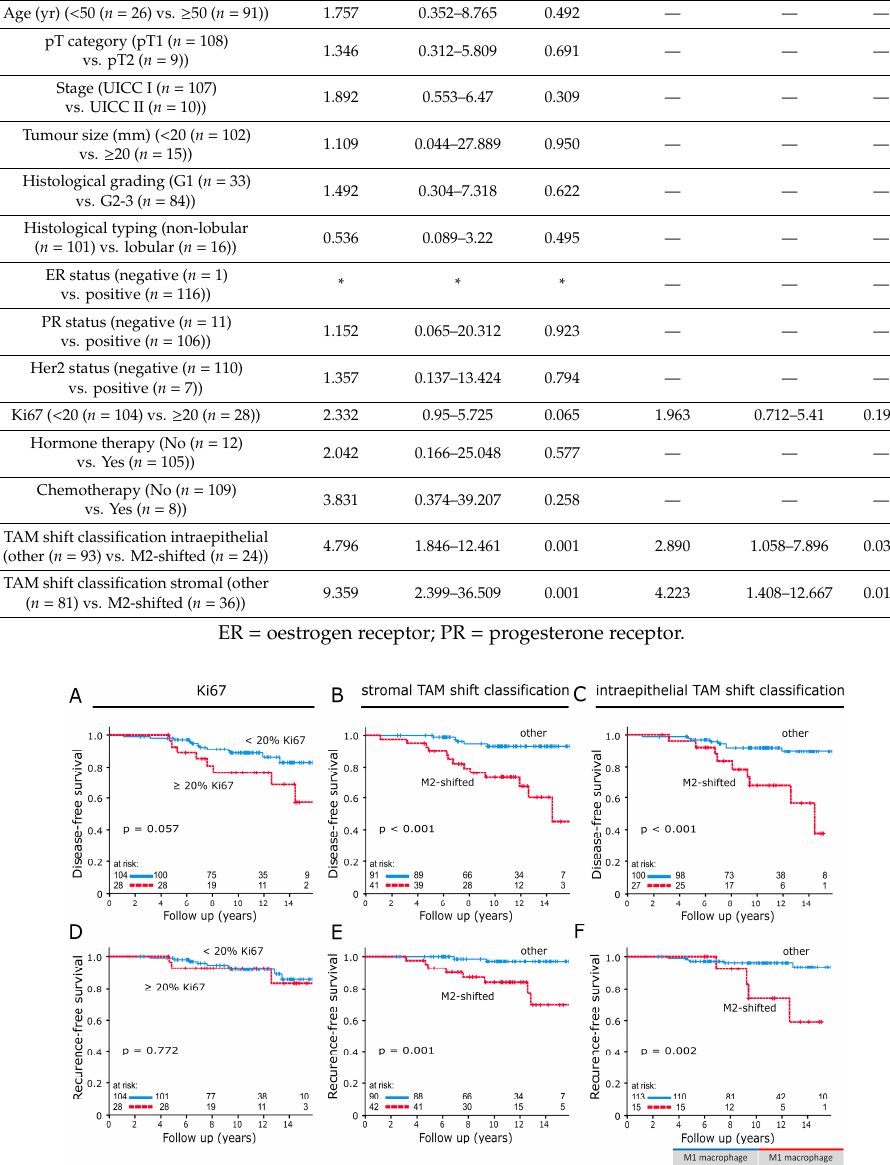
(Figure 4A–F). No statistically significant correlations between macrophage shift classifications and